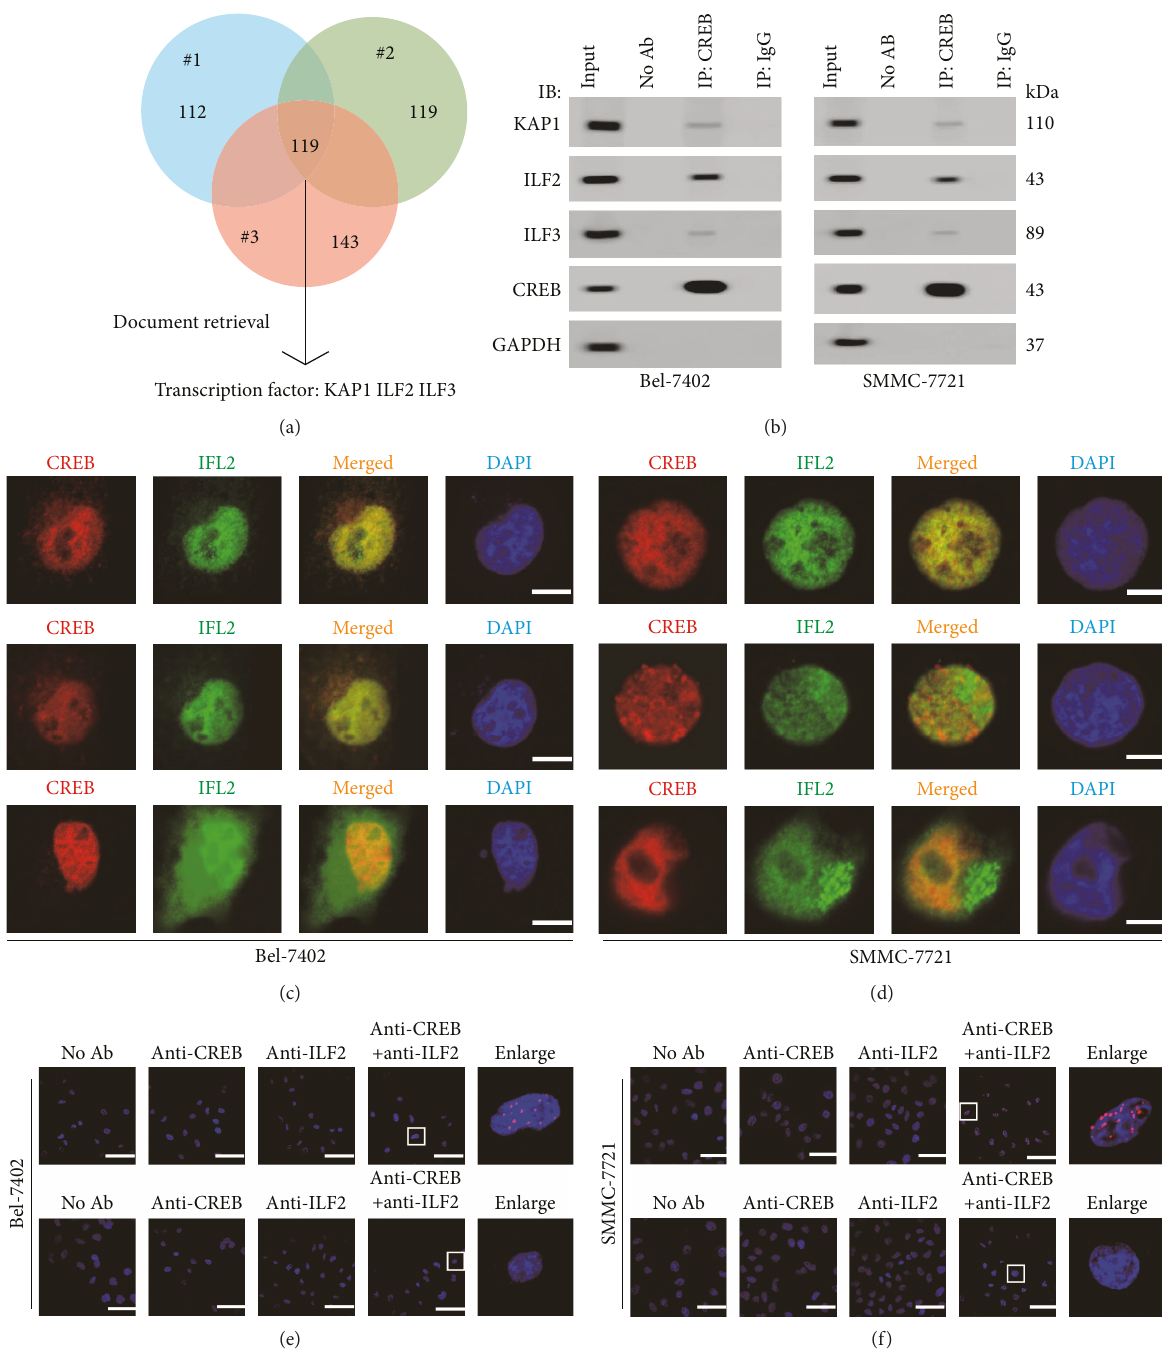
Figure 1: ILF2 was identi fi ed to directly interact with CREB. (a) MS analysis of CREB-binding proteins. The proteins immunoprecipitated by anti-CREB antibodies were analyzed by ESI-Q-TOF-MS in Bel-7402 cells for three independent times. (b) Endogenous CREB was immunoprecipitated by anti-CREB antibodies in Bel-7402 and SMMC-7721 cells, and the indicated proteins were measured by WB. The negative control for IP was immunoglobulin G (IgG). (c, d) The colocalization of CREB and other transcription factors in Bel-7402 and SMMC-7721. The nuclei were stained with DAPI. Representative images of three independent experiments were shown. Cells were obtained for IF by anti-CREB and corresponding antibodies. Scale bar, 15 μ m. (e, f) The interactions between CREB and ILF2 or ILF3 were analyzed by PLA. The rightmost graphic was the enlargements of the boxes. Scale bar, 50 μ